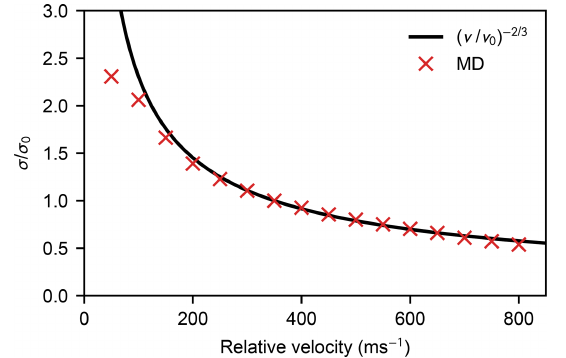
Figure 7. Collision rate coefficient β (a) and the enhancement fac- tor W (b) as a function of temperature calculated for the hard- sphere, MD, Langevin, and Brownian